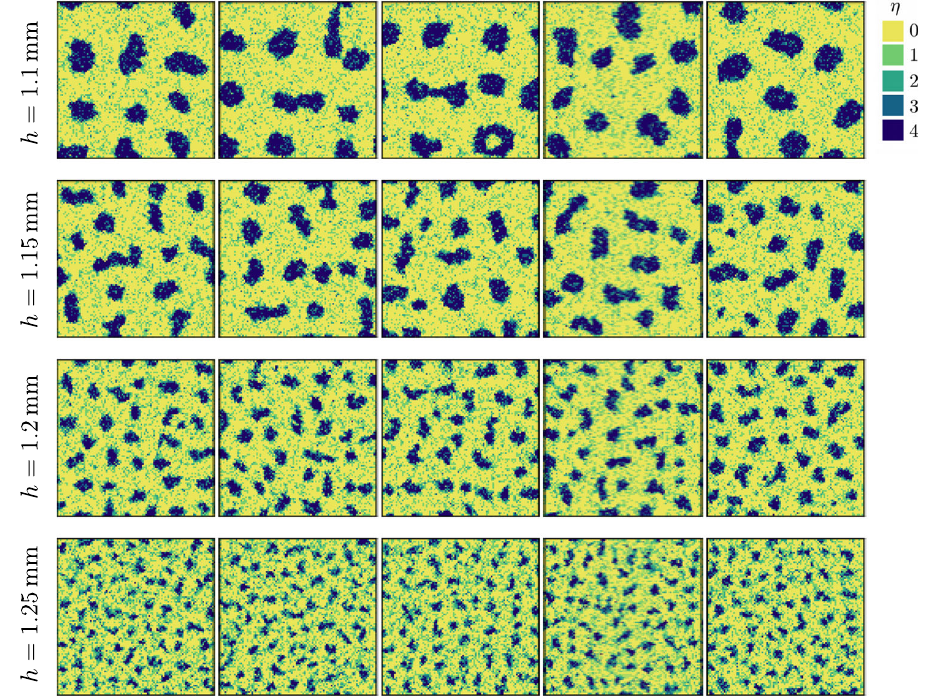
Fig. 5 | Aggregates in the cell-based simulations for various fi lm height h . The average density is (cid:1) ρ =10 6 cm − 2 , the system size L =100 (cid:1) b =1mm, and the simulations involve 10 4 cells. From top to bottom, the aggregates have typical